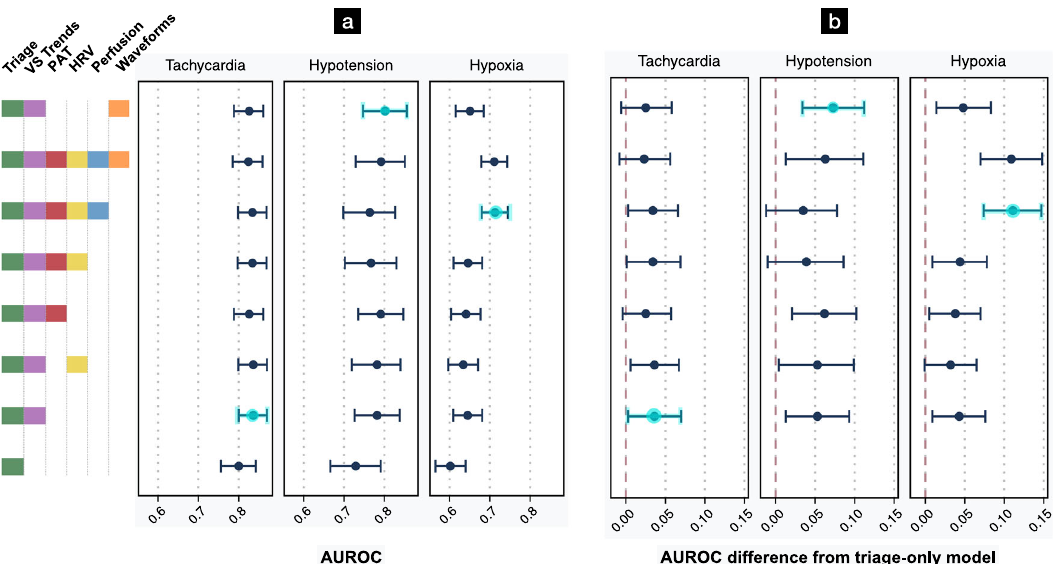
Fig. 2 Effect of feature types on AUROC for prediction of decompensation. a AUROC point estimates with bootstrapped 95% CIs represent prediction performance on the test set (see also Supplementary Tables 1-2). b AUROC differences from the baseline triage model with 95% CIs. For each outcome, additional monitoring features produced more accurate predictions than the baseline triage model. “ Triage ” variables include age, gender, triage vital signs, and chief complaint. “ VS Trends ” denotes fi rst vital signs from continuous monitoring, and the linear trend of each vital sign over a 15-minute assessment period. “ PAT ” denotes pulse arrival time, calculated from the ECG and PPG waveforms. “ HRV ” is a suite of heart rate variability measures. “ Perfusion ” is the perfusion index. “ Waveforms ” indicates an 8-dimensional embedding generated from a transformer model, with 4 features each from the PPG and ECG waveforms. The best-performing model for each outcome is highlighted in light predictions of speci fi c abnormalities (tachycardia, hypotension,